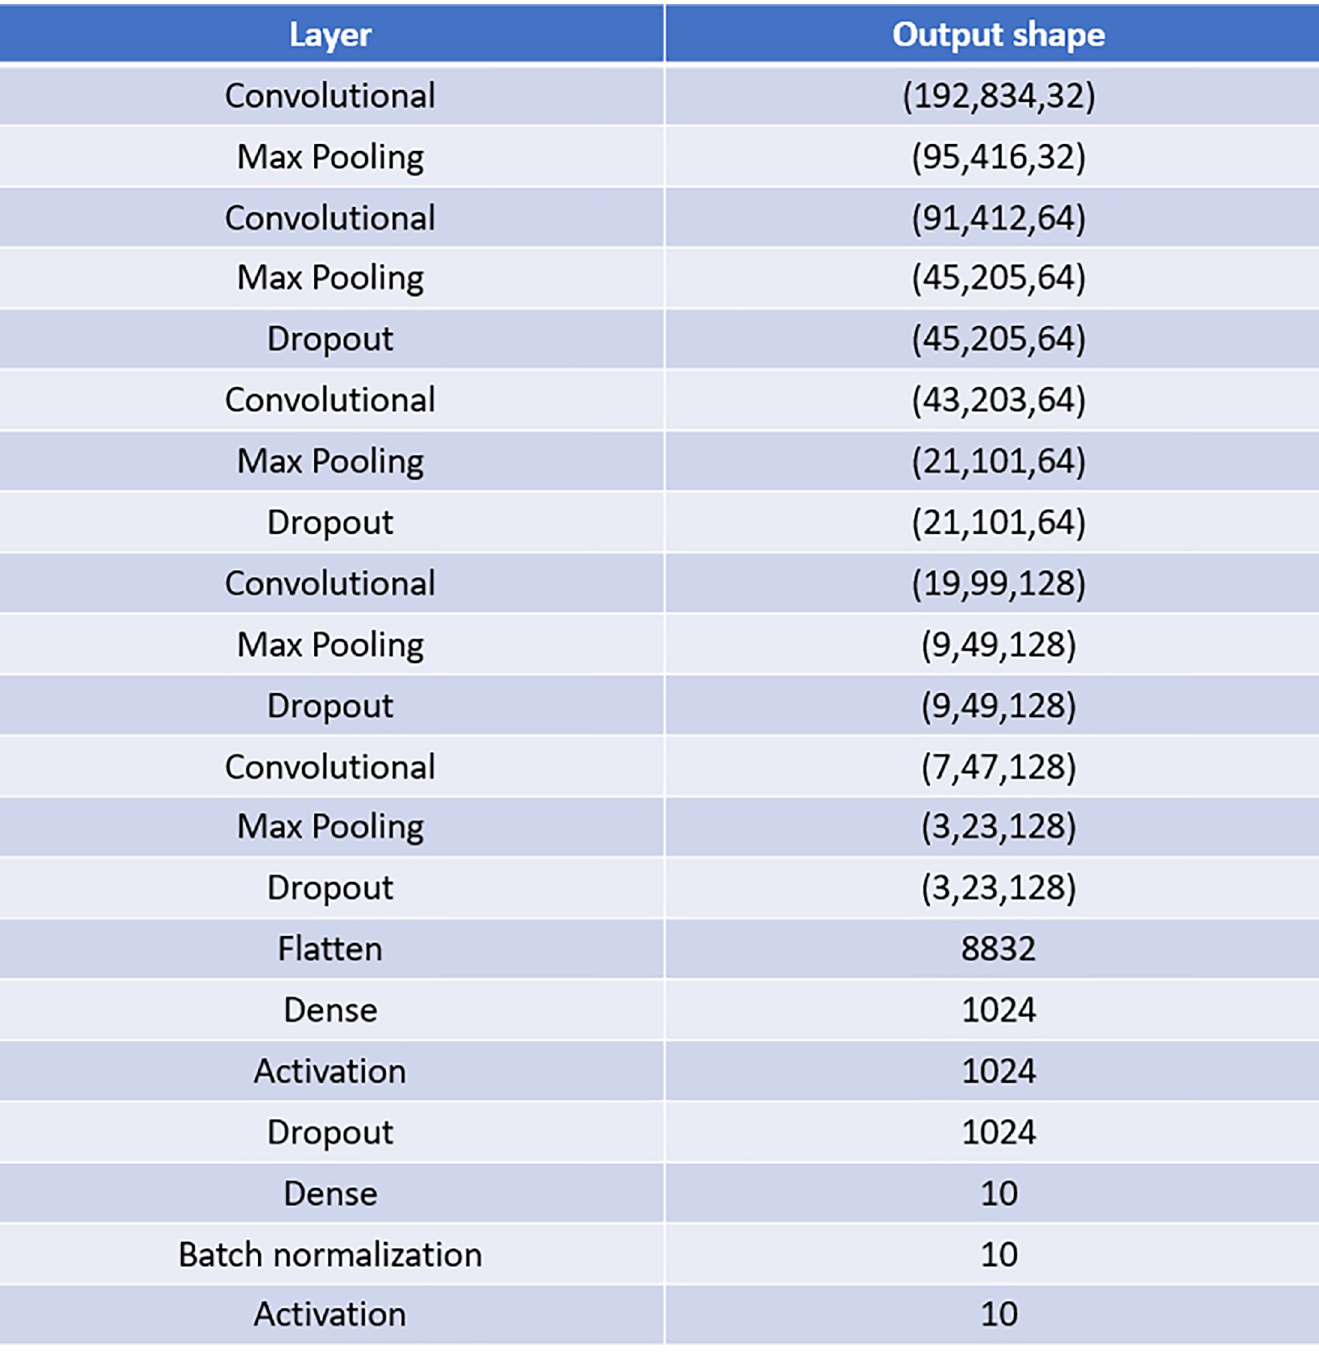
Fig 3. Scheme of the proposed CNN architecture. The figure reports the table that evidences the layers composing the designed CNN architecture; here the output shape is in the form ( width , height , depth ). find the best parameters such as the kernel type (radial basis function, linear, polynomial, sig- moid), the features normalization and scaling, the number of features (15, 13, 11, 9, 7, 5, and 3, obtained by applying a Principal Component Analysis) and other parameter values such as the